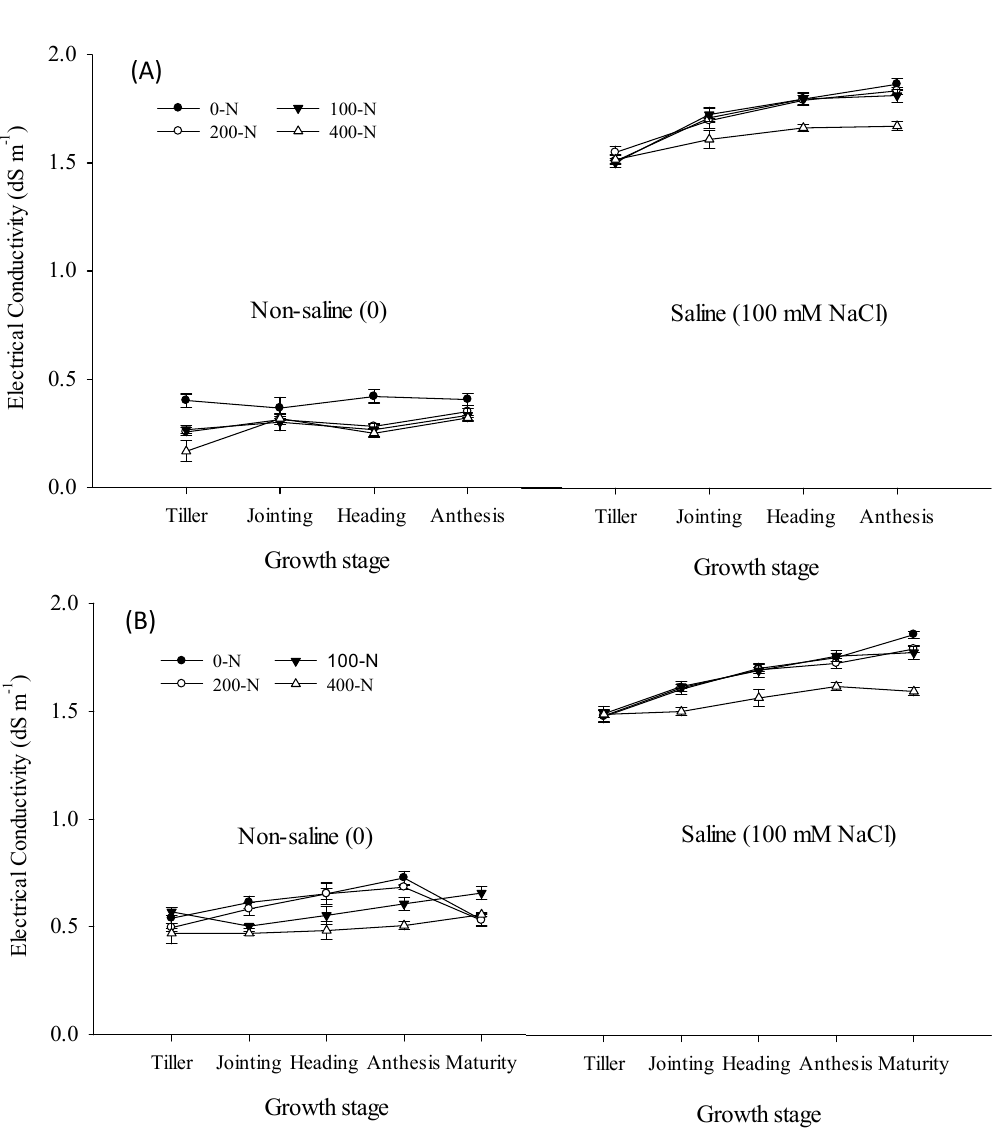
Figure 1. Changes in electrical conductivity (EC) of potting media at a 15 cm depth during the whole growth stage. ( A ) represents the first run. ( B ) represents the second run.